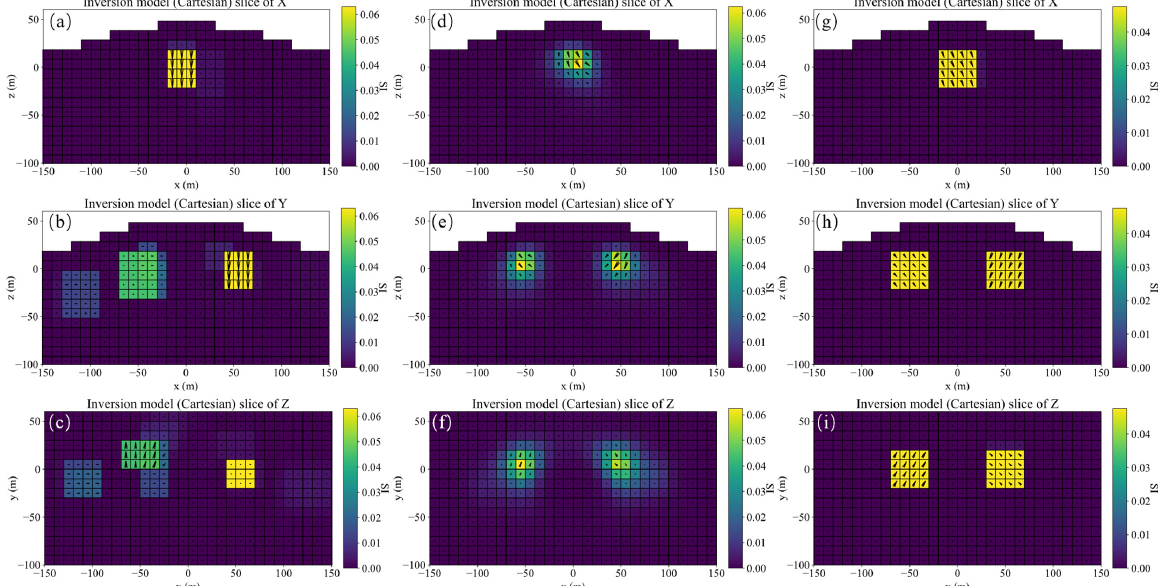
Figure 11. Slices along the X, Y, and Z directions of the magnetization vector models inverted by method 1 ( a – c ), method 2 ( d – f ), and method 3 ( g – i ), respectively.